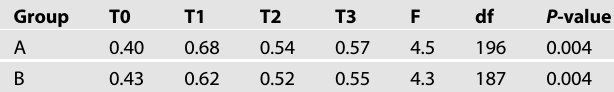
Table 1. One way ANOVA for salivary fl ow rate analysis in different time points.